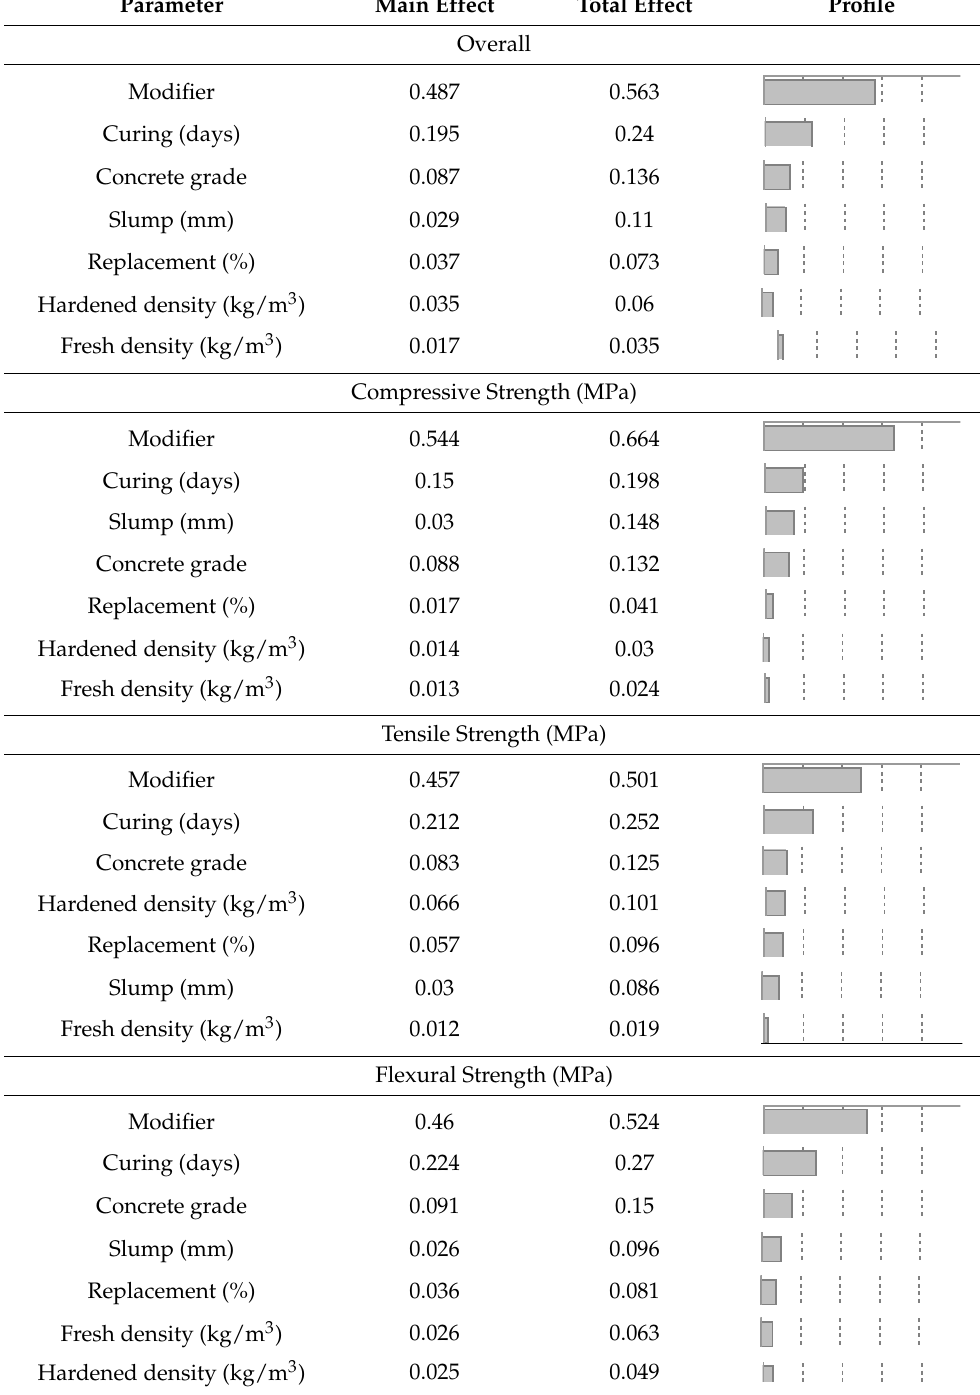
Table 6. Impact and variable importance of all parameters.